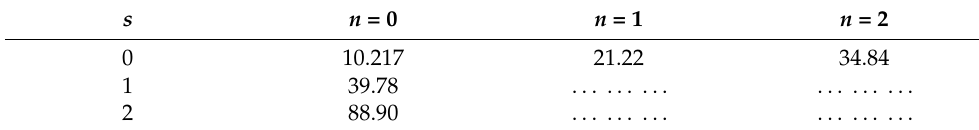
Table 11. Some results of natural frequencies by analytical calculus Power coef.